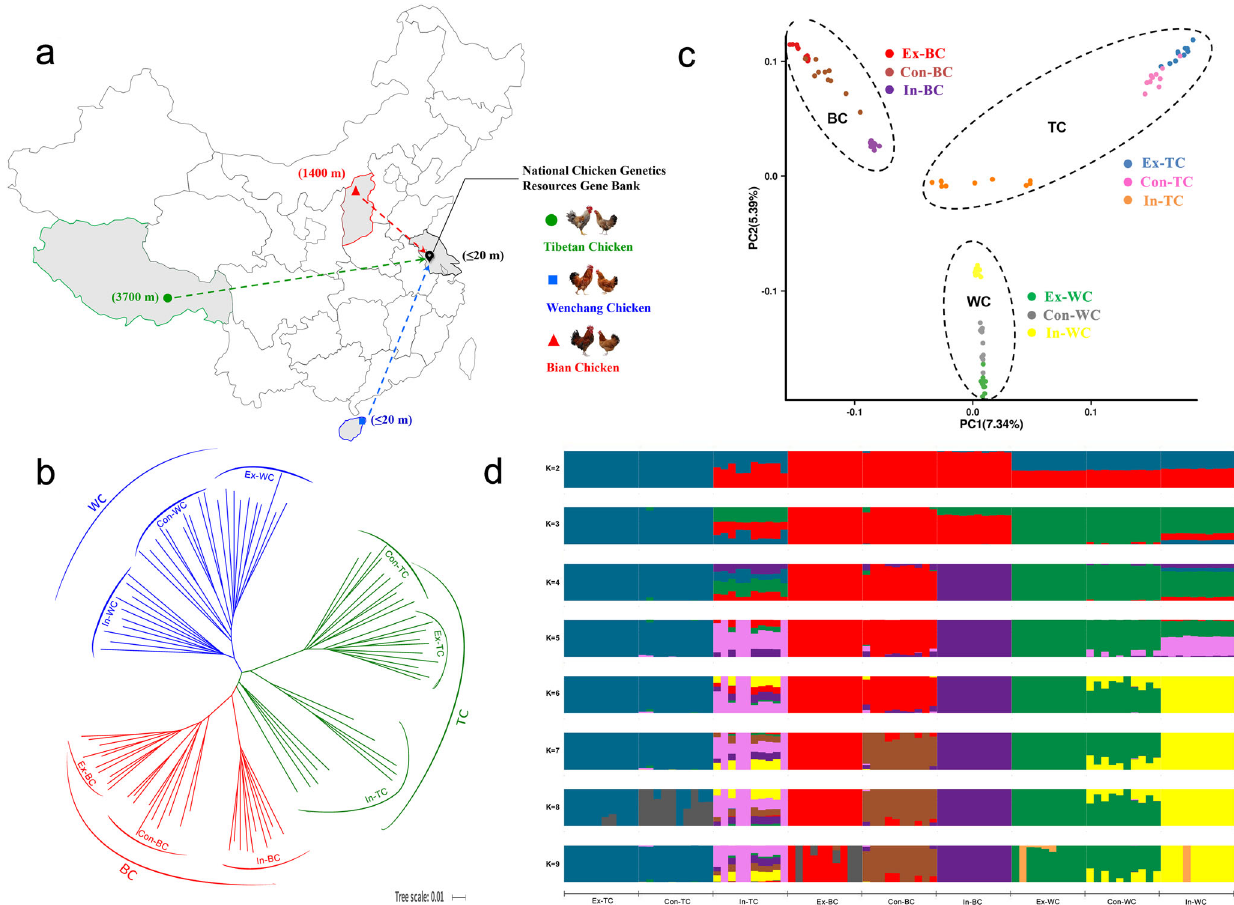
Fig. 1 Sample distribution, phylogenetics and population structure of indigenous chicken breeds during different conservation programmes. a Geographic distribution of three selected indigenous chicken breeds. b The neighbour-joining tree of 90 indigenous chickens (TC: Tibetan chicken, WC: Wenchang chicken and BC: Bian chicken). Each breed was divided into three groups according to the conservation programmes (Con – cryopreserved samples, as a control, NCF; In – in situ conservation, NCF; and Ex – ex situ in vivo conservation, NCGR). c The principal component analysis (PCA) of 90 indigenous chickens. d Structure analysis of nine populations from three indigenous chicken breeds. Groupings of samples from 2 – 9 ancestral clusters ( K ) are